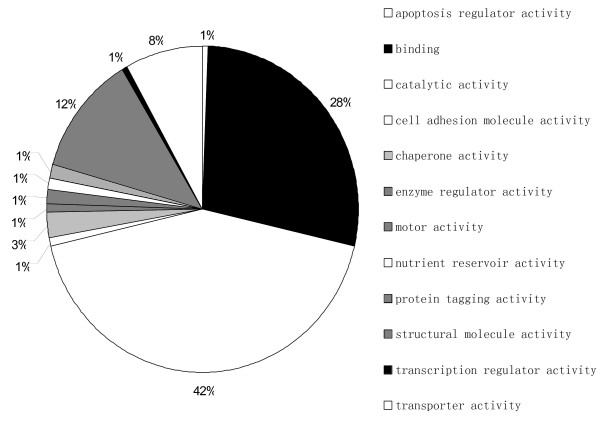
Assignment of the 439 ESTs spotted on the “Forage quality array” to functional classes by GO vocabularies.   Each EST was assigned with GO vocabularies according to the TIGR Maize Gene Index [12]. Unclassified ESTs (66%) were not taken into account.